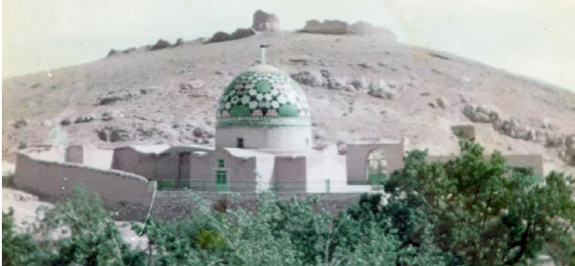
Figure 3. Imamzadeh of the village and the remains of the citadel, 1965, Banadkok.blogfa.com.